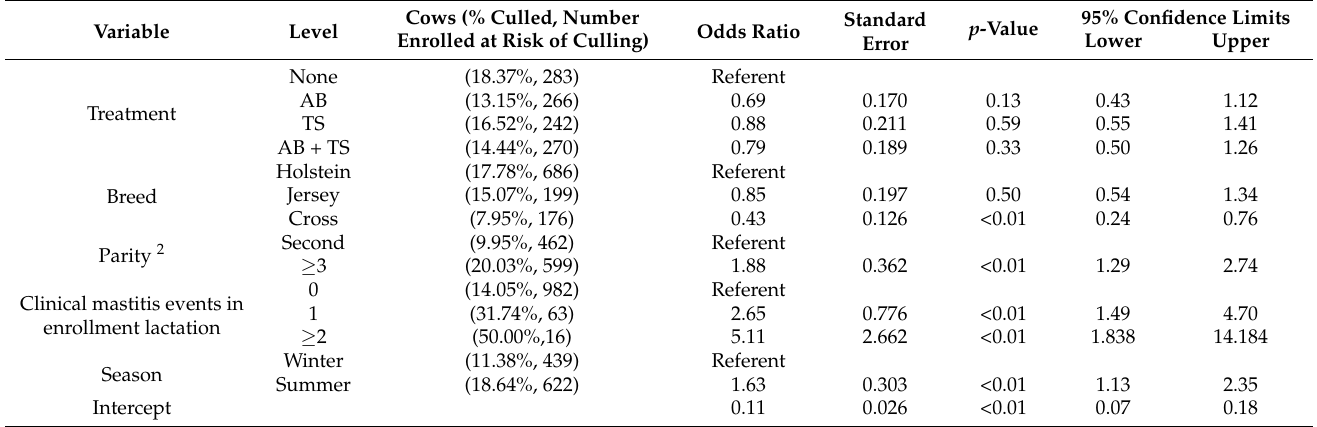
Table 5. Logistic regression model predicting culling after calving up to 150 days in milk among different treatment groups (AB, TS, AB + TS, None) 1 on California dairies ( n = 8 herds).